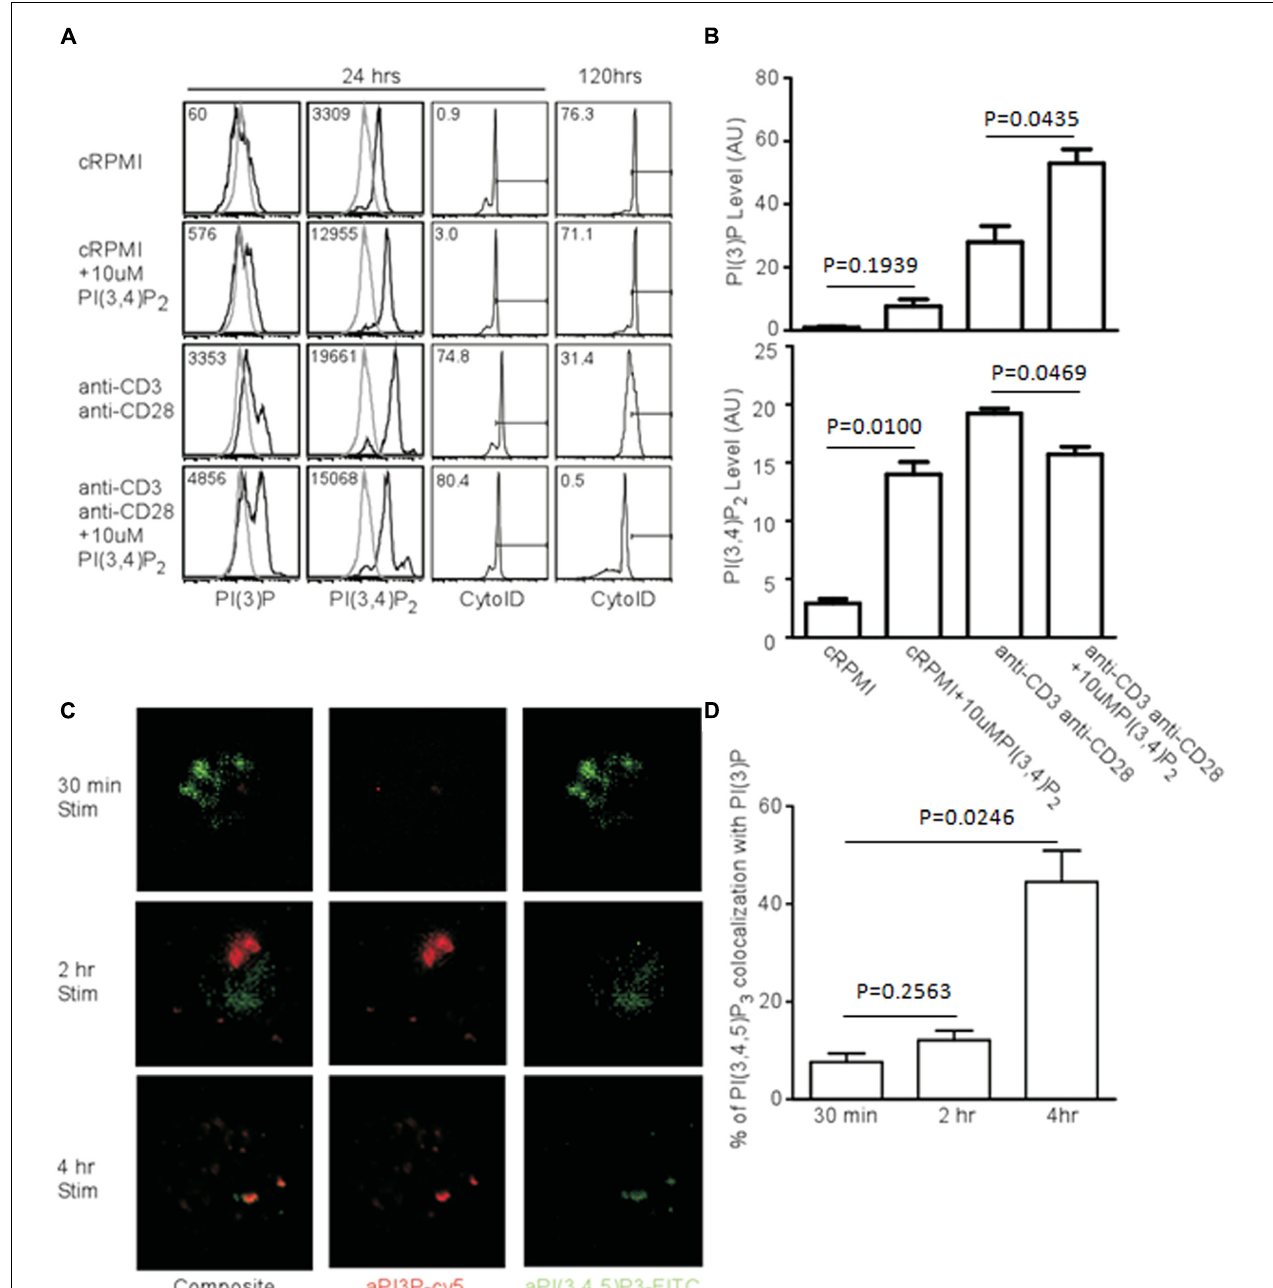
FIGURE 6 | Exogenous PI(3,4)P 2 alters the autophagic profile and is converted to PI(3)P. ( A , left panel) Histograms of relative levels of PI(3)P and PI(3,4)P 2 CD4 T cells were loaded with 10 µ M PI(3,4)P 2 and stimulated with 1 µ g/mL soluble anti-CD3 and anti-CD28 for 24 and 120 h. PI(3,4)P 2 is largely converted to PI(3)P only after TCR stimulation. ( A , right panel) AVO formation of CD4 T cells loaded with PI(3,4)P 2 . Exogenous PI(3,4)P 2 effects an accelerated autophagic profile that is resolved by 120 h compared to unloaded controls. (B) Quantification of phosphatidyl inositol levels from CD4 T cells left untreated or loaded with PI(3,4)P 2 and stimulated for 24 h as in (A) . Data represent 4 replicates from 3 independent experiments. (C) Fluorescence microscopy of phosphatidylinositol species in T cells activated with plate-bound anti-CD3 and anti-CD28 for the indicated time periods. (D) Quantitation of colocalization of phosphatidylinositol species from (C) .